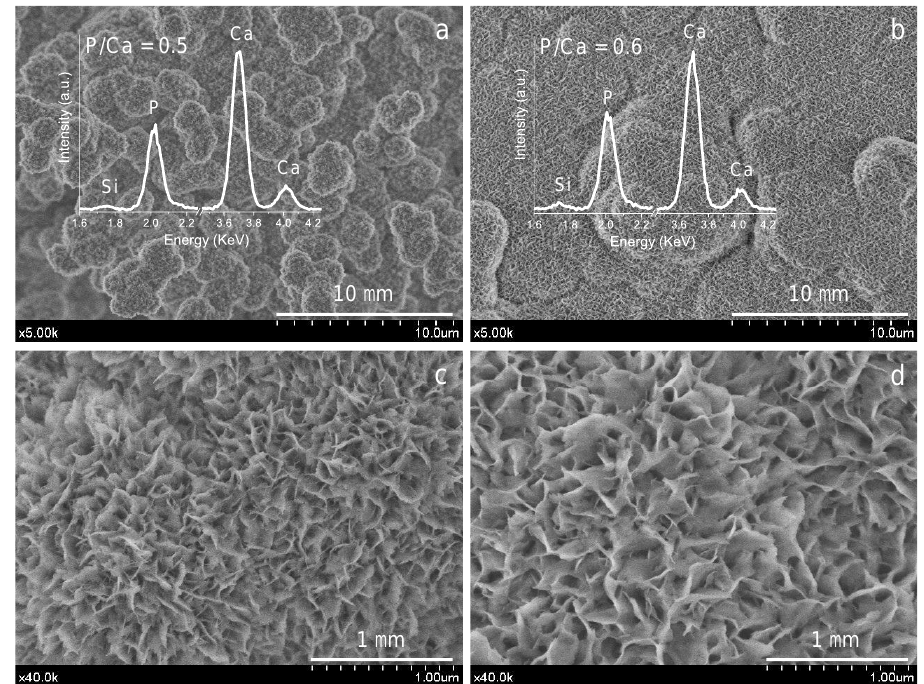
Figure 11. FEG-SEM observations and EDX analysis of hydrated ACaNO-HNO formulation surfaces after 7 days SBF essay: ( a , c ) without post-synthesis treatment; and ( b , d ) after EPT.